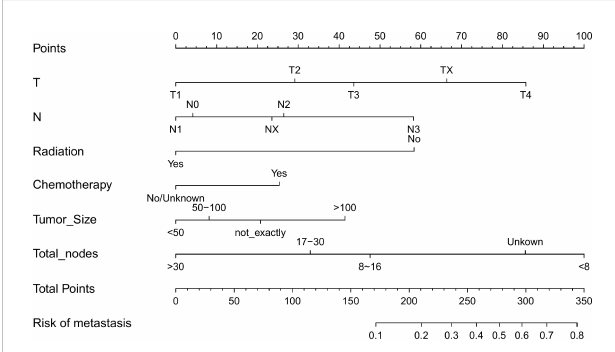
FIGURE 4 Nomogram for predicting DM in the training set of early-onset GC(C). DM, distant metastasis; GC, gastric cancer.